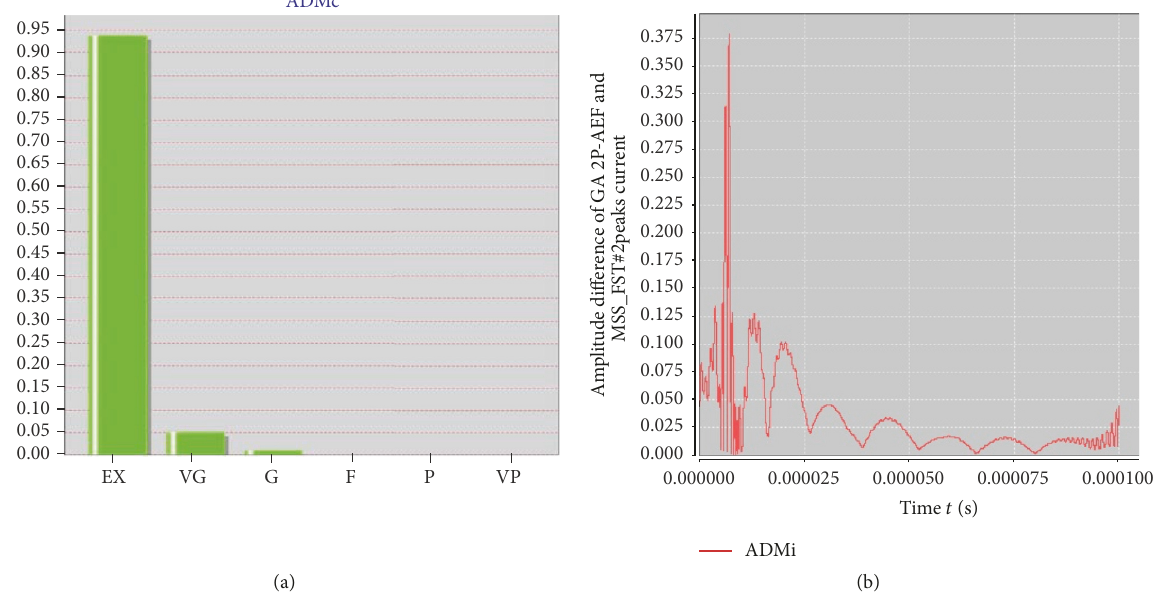
Figure 11: (a) ADMc and (b) ADMi obtained by FSV applied to MSS FST#2peaks results [20] and its approximation by 2P-AEF(2,1,2) using GA for parameters evaluation.